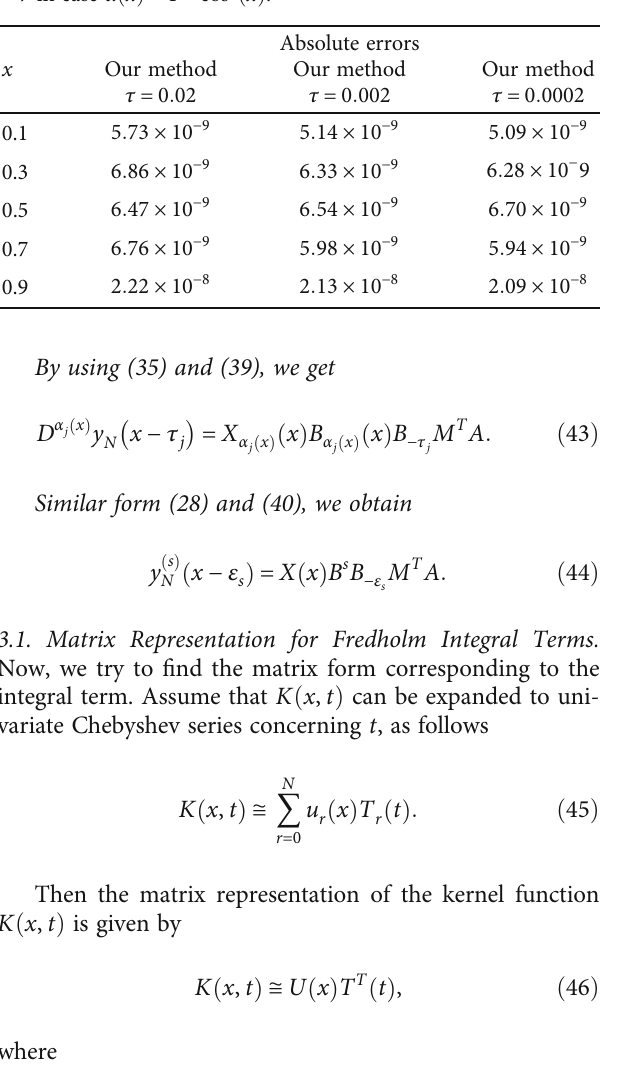
Table 3: The comparisons between the absolute errors of the presented method for Example 2 with di ff erent values of τ and N = 7 in case α ð x Þ = 1 − cos 2 ð x Þ